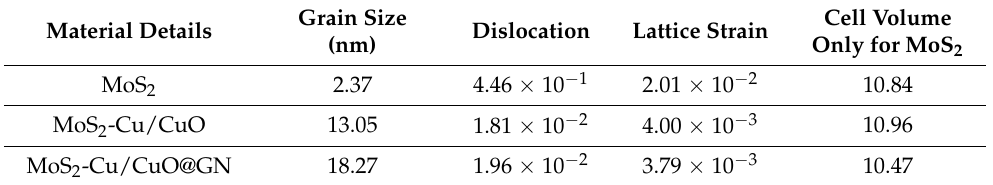
Figure 1. Diffraction analysis ( a ) and grain size calculation ( b ) for MoS 2 , MoS 2 -Cu/CuO and MoS 2 -Cu/CuO@GN. Table 1. Calculated structural parameters for MoS 2 , MoS 2 -Cu/CuO and MoS 2